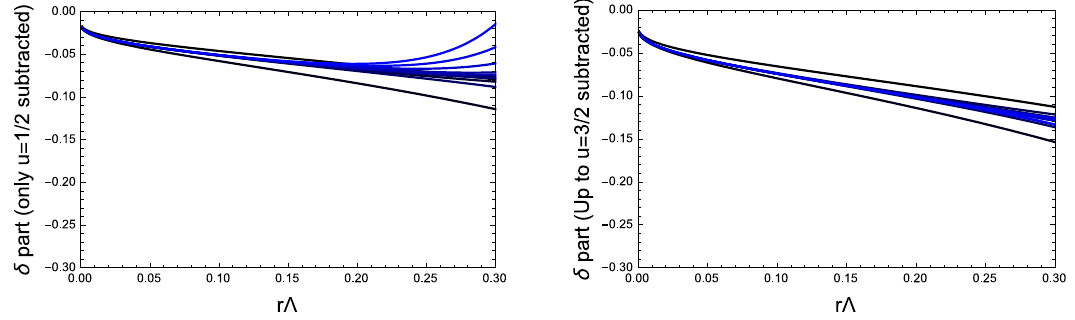
Figure 9 . Perturbative series of the (cid:14) part for the dimensionless potential. In the left panel, only the u = 1 = 2 renormalon is subtracted, while in the right panel, up to the u = 3 = 2 renormalon is subtracted. Deeper blue line corresponds to higher order result. The highest order is O ( (cid:11) 11